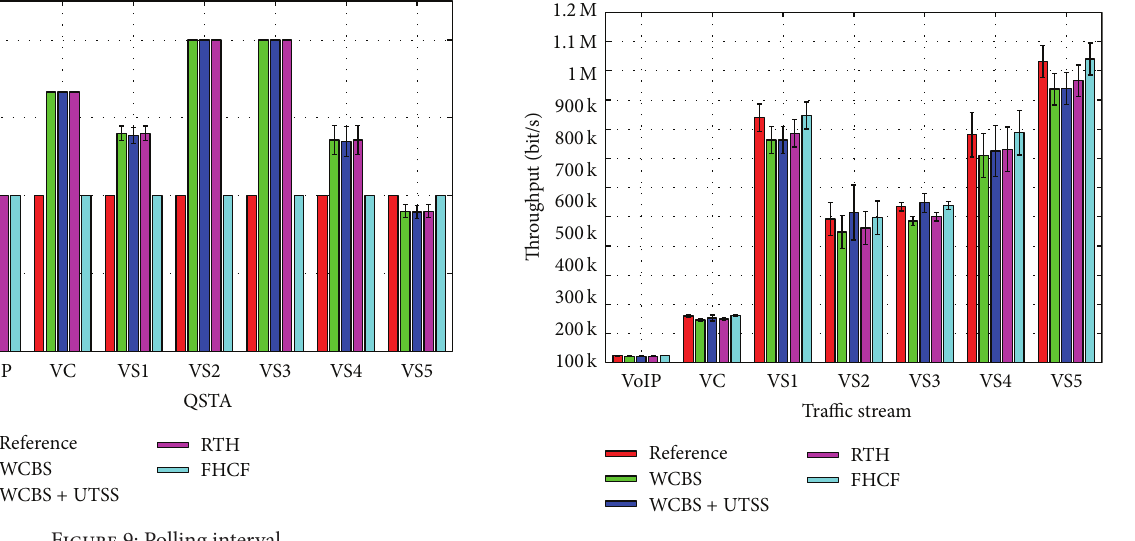
Figure 10: Throughput of VBR stations.